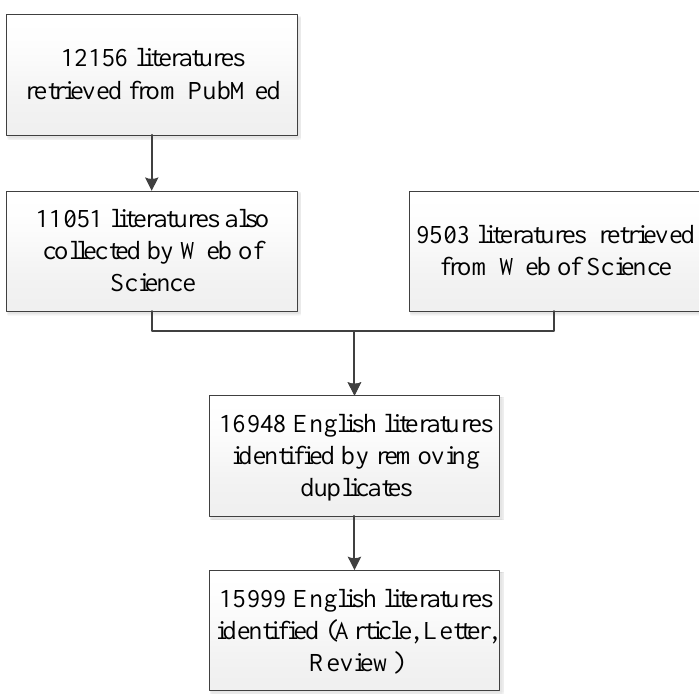
Figure 1. The flowchart of the research to search papers in databases.